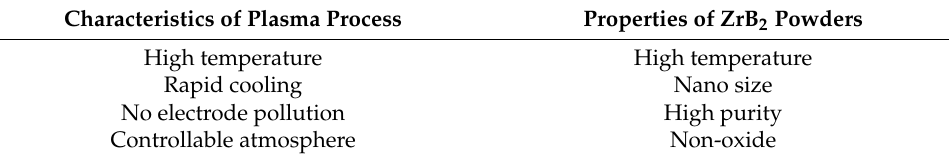
Table 2. Comparison list between the characteristics of plasma process and the properties of ZrB 2 powders.